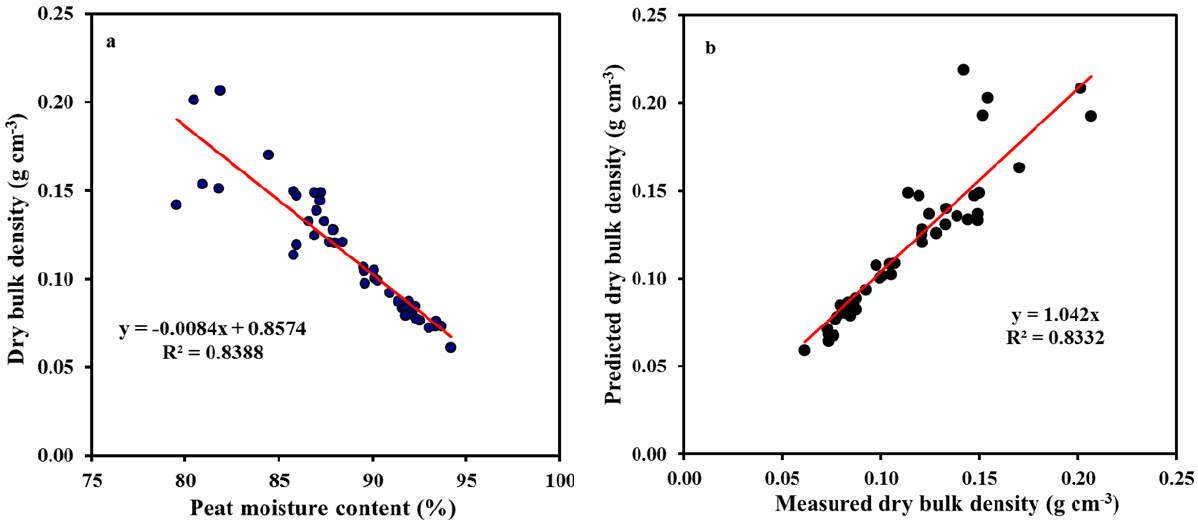
Figure A1. Regression of measured dry bulk density on gravimetric moisture content (a) and of predicted dry bulk density on measured dry bulk density (b) for a set of Scottish basin, blanket and semi-confined peats (Middlemuir, Red Moss, Shetland and Allt a’Mharcaidh).